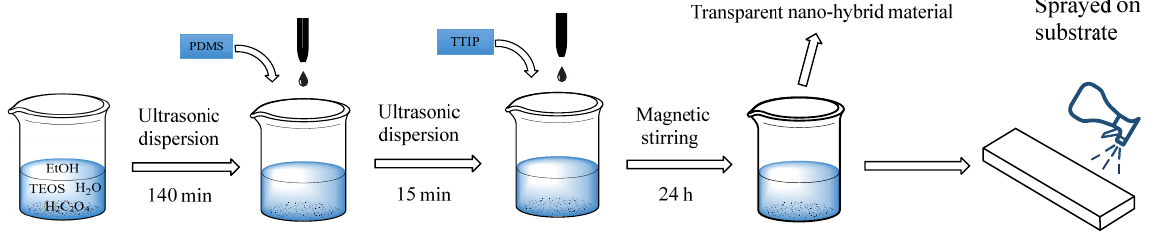
Figure 1. Preparation process of the coating.